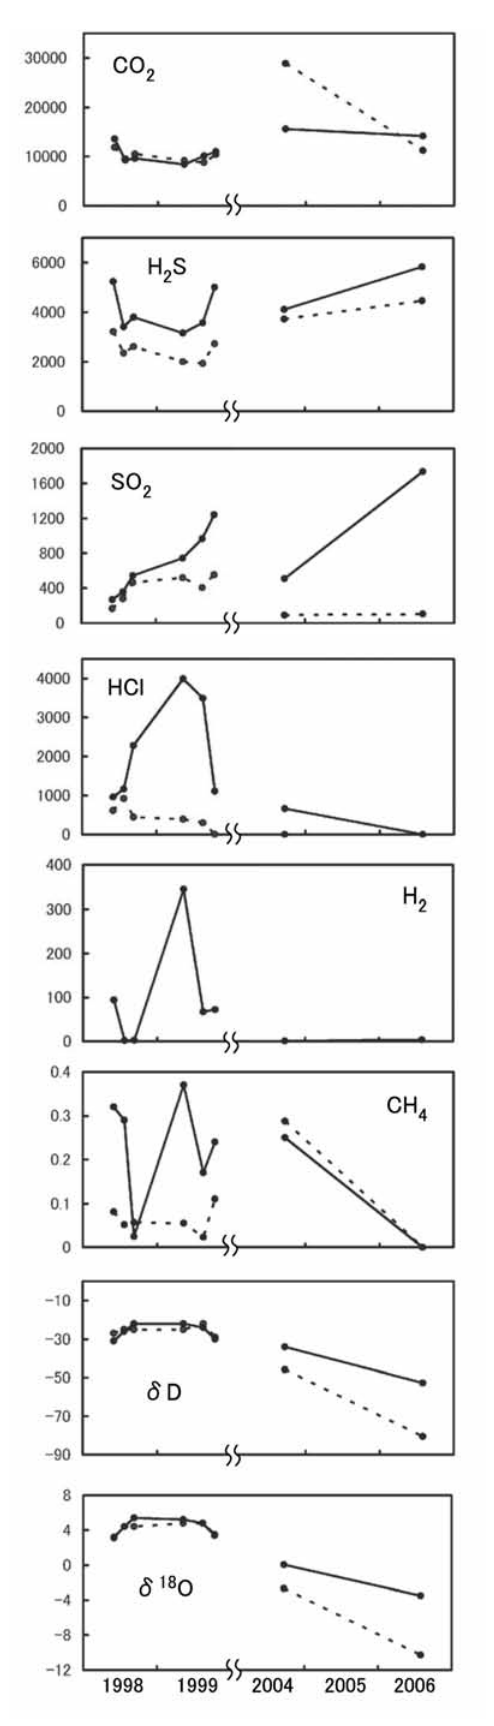
Figure 3. Temporal variations in the compositions ( μ mol/mol) and isotope ratios (‰ relative to SMOW) of the water in the fumarolic gases from site J (as indicated). Solid and dotted lines, JA and JB series, respectively.